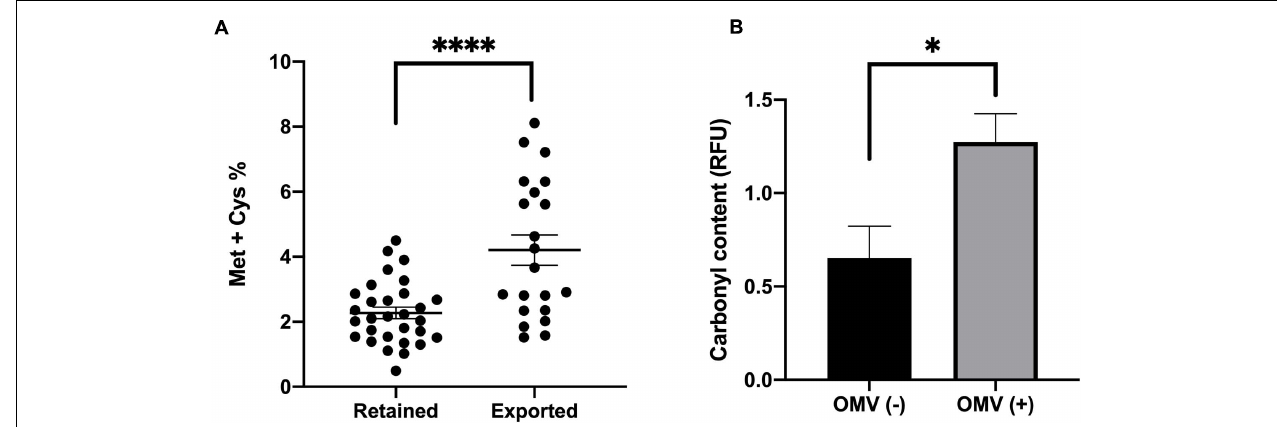
FIGURE 2 | Levels of oxidizable residues and oxidized proteins are increased in OMV cargo in response to oxidative stress. (A) Methionine and Cysteine percentage (Met and Cys residues per total amino acids in protein without initial Met) in preferentially exported vs. preferentially retained proteins in oxidized samples. (B) Densitometric Oxyblot analysis of OMV proteins from 3 h H 2 O 2 treated (+) or untreated (–) ETEC cultures using FIJI software and normalized to non-derivatized samples ( n = 6). Error bars are SEM. P -values according to the Student’s t -test: ∗ p ≤ 0.05, ∗∗∗∗ p ≤ 0.0001.